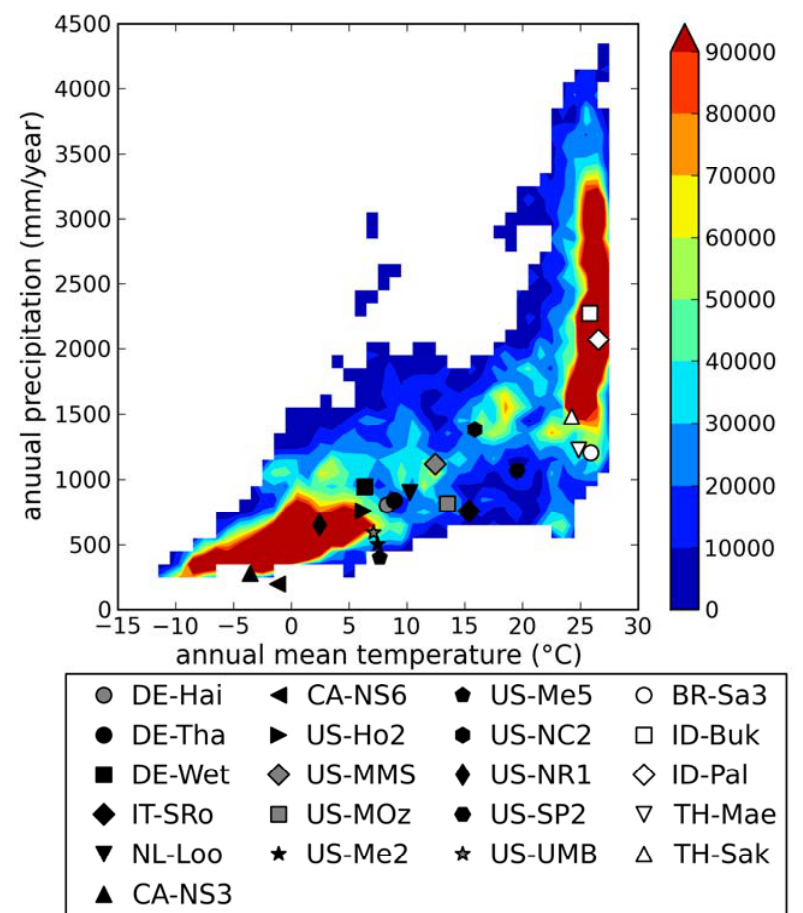
Figure 2. Scatterplots of flux tower sites over the global climatology contour plot in the temperature-precipitation domain. The temperature and precipitation of flux towers are averaged measured values in the years when gross primary production (GPP) is available for analysis. The temperature and precipitation of the global climatology were calculated using Climate Research Unit (CRU) datasets from 1982 to 2009 base years. The contour are area-weighted histogram and the units of the color scale is km 2 /(1 °C)/(1 mm) bins. Only forested areas were plotted (as identified by MCD12C1 IGBP classification land cover